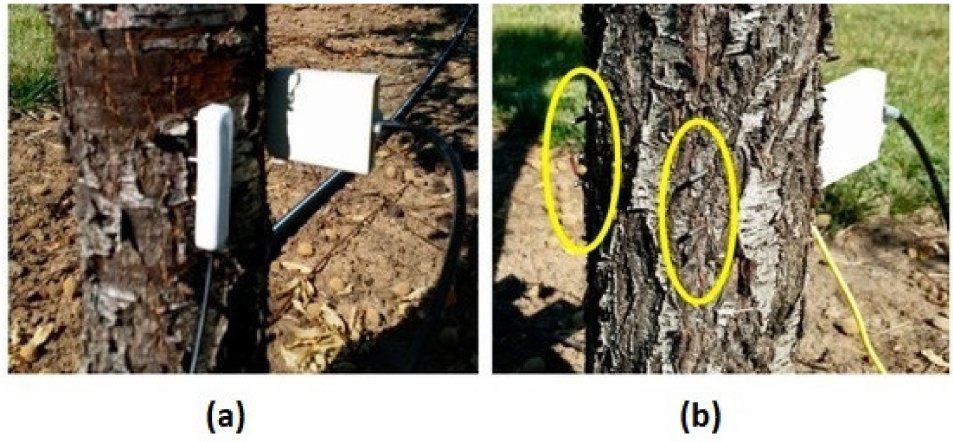
Figure 6. VSWC sensors inserted into peach tree trunks: ( a ) The Decagon Devices GS3 and Campbell Scientific CS655 sensors; ( b ) The Campbell Scientific CS655 and Acclima TDR-315L sensors